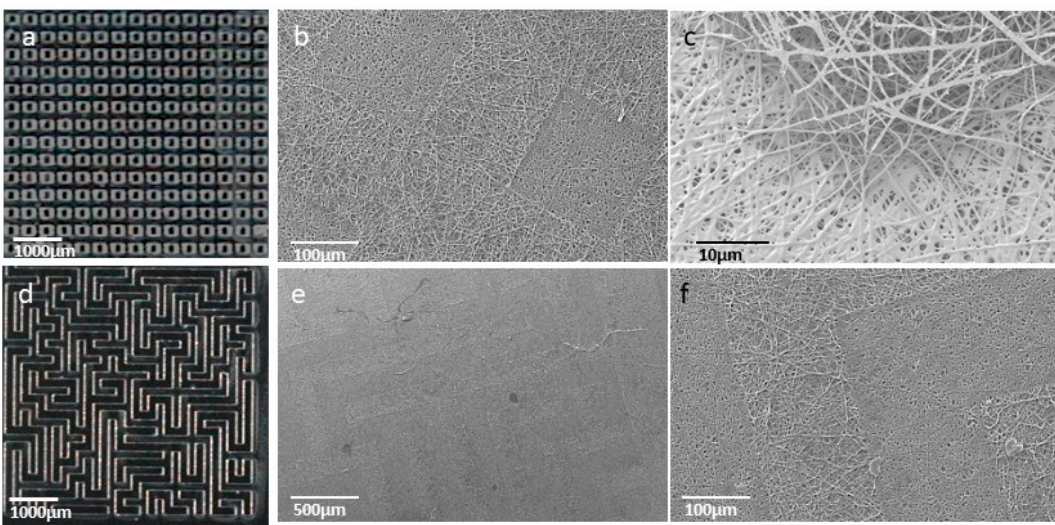
Figure 5. Optic images of 200 µ m row and maze patterned molds ( a and d , respectively) and SEM images of 200 µ m patterned GelMA electrospun mats ( b and c : row patterns; e and f : maze patterns).